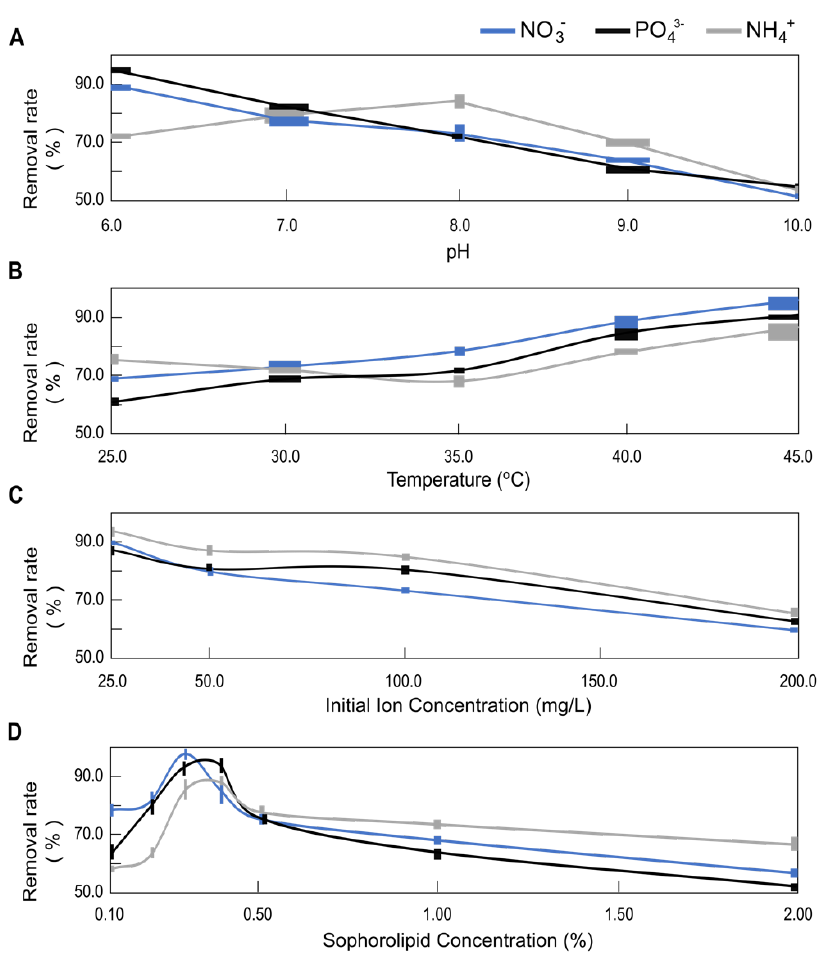
Figure 2. Effect of ( A ) pH, ( B ) temperature, ( C ) initial ion concentration, and ( D ) sophorolipid con- centration on the removal rate of NO 3 − , PO 43 − , and NH 4+ .